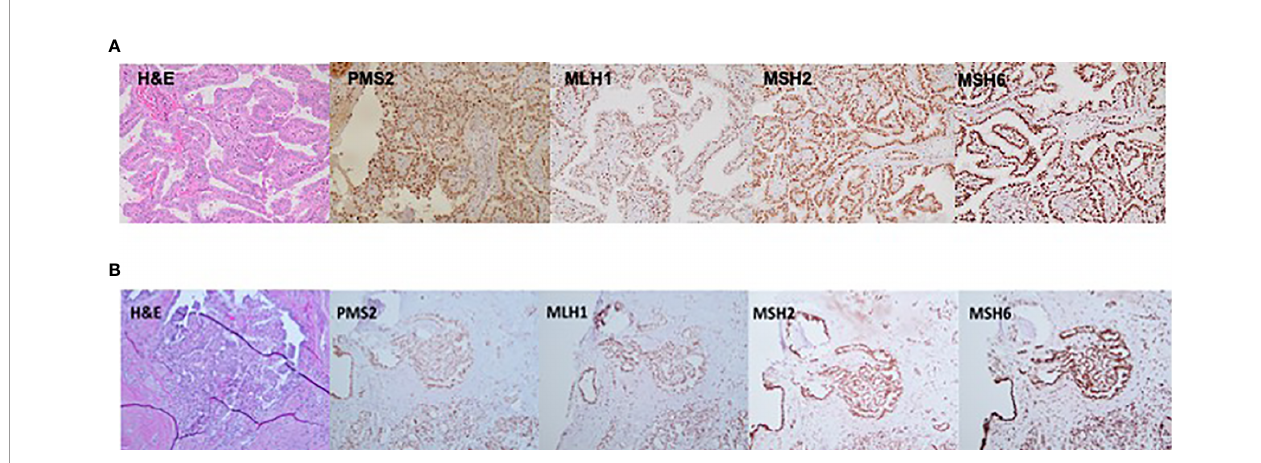
FIGURE 3 | Immunostaining (20×) demonstrating an intact nuclear expression of mismatch repair (MMR) proteins — PMS2, MLH1, MSH2 , and MSH6 in thyroid cancer tissue derived from (A) patient III.1 and (B) patient